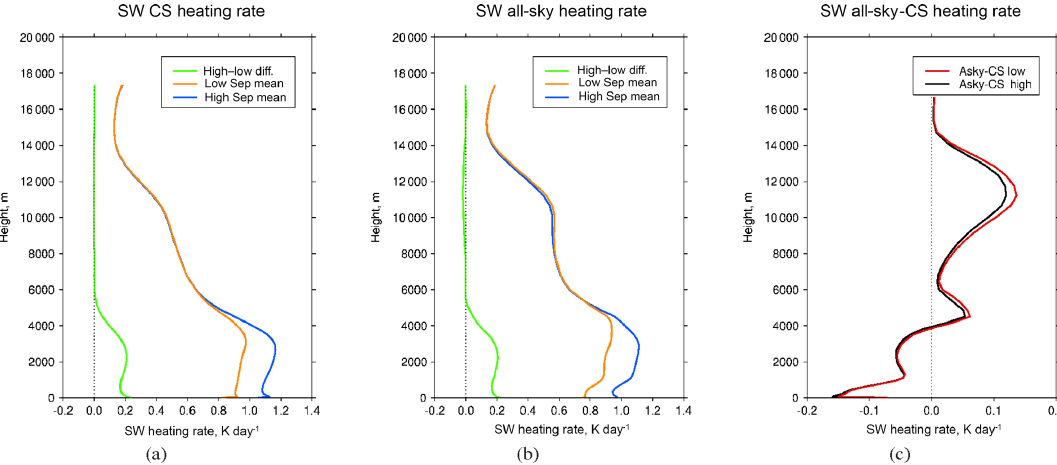
Figure 12. September mean SW heating rates (averaged over the BB box 5–25 ◦ S, 40–70 ◦ W) for high and low emissions: (a) clear sky, (b) all-sky and (c) all-sky–clear-sky differences, showing heating rate changes due to cloud only.